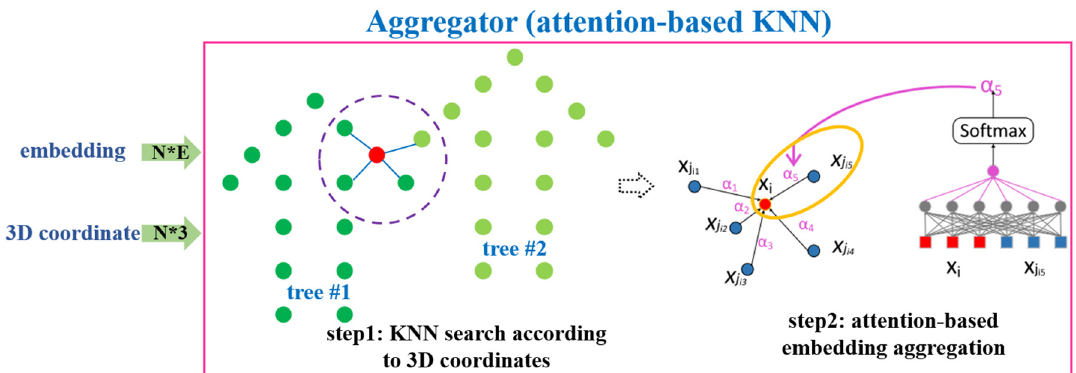
Figure 7. Illustration of the aggregator using attention-based KNN.